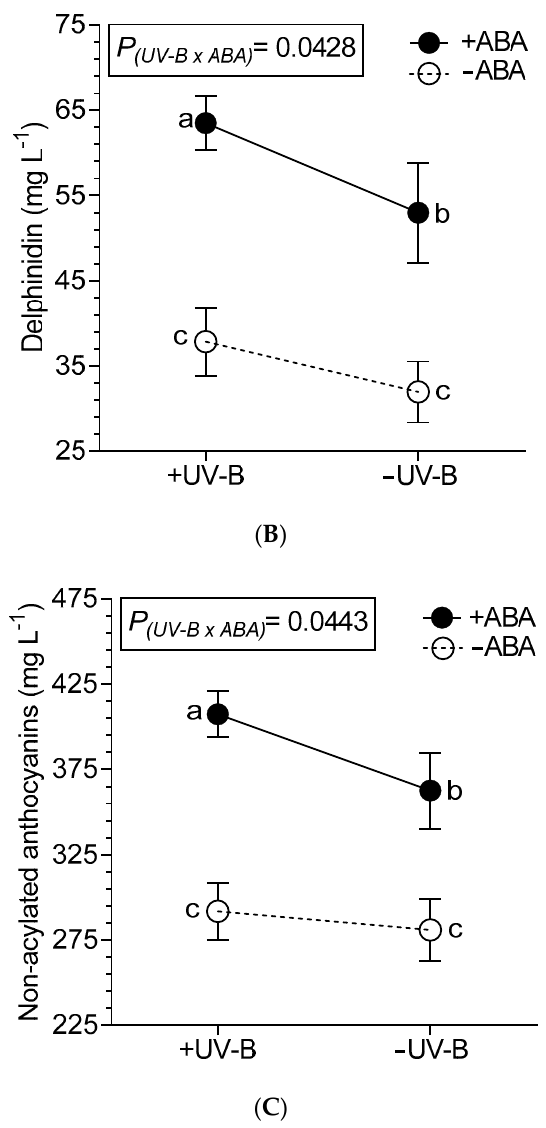
Figure 2. Interaction between UV-B and ABA for peonidin content ( A ), delphinidin content ( B ) and total non-acylated anthocyanins ( C ) determined in wines from Malbec plants exposed to combined UV-B, WD and ABA treatments. Values are means for each factor combination ±SEM (n = 3) and different letters indicate significant differences (Fisher’s LSD, p ≤ 0.05).